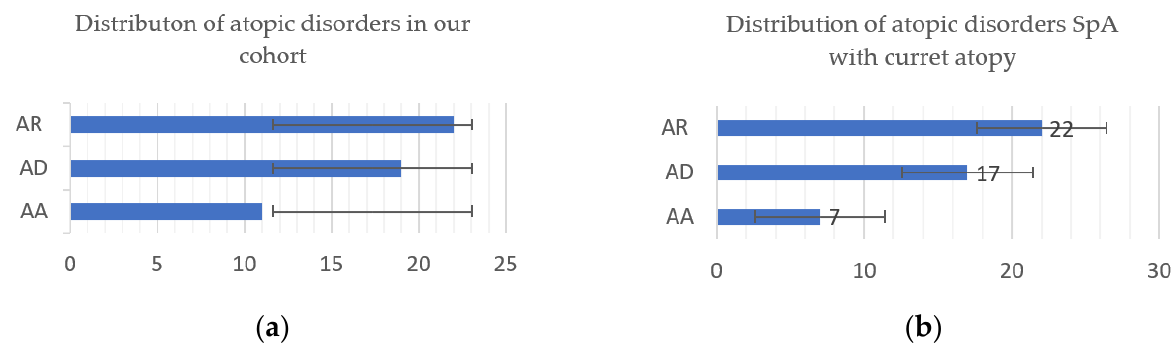
( b ) Figure 1. SpA patients with and without atopy: ( a ) PsA; ( b ) axSpA; ADs, atopic disorders. We further assessed the percentage of patients with different subtypes of atopy, tak- ing into account all 51 patients with SpA and atopic symptoms sometimes during their life. Some of them have overlapping two atopic disorders, such as allergic rhinitis and atopic dermatitis or rhinitis and asthma. Hence, when analyzing different atopic condi- tions separately, we reported a higher frequency of rhinitis (22, 43%) versus atopic eczema (19, 37.2%) or asthma (11, 21.5%) (Figure 2a). A closer look showed that 46 patients who positively answered questions Q2, Q3, and Q4 have current atopy: 7 patients under con-